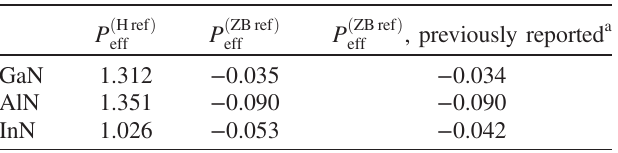
TABLE I. Effective spontaneous polarization constants in units of C = m 2 of WZ GaN, AlN, and InN calculated using either the hexagonal (H, space group P 6 3 =mmc ) or ZB (space group F ¯43 m ) reference structures. The lattice constant of the ZB structure is chosen to match the in-plane lattice constant of the WZ structure for the same material. Results from previous calculations [7] that used the ZB reference are listed for